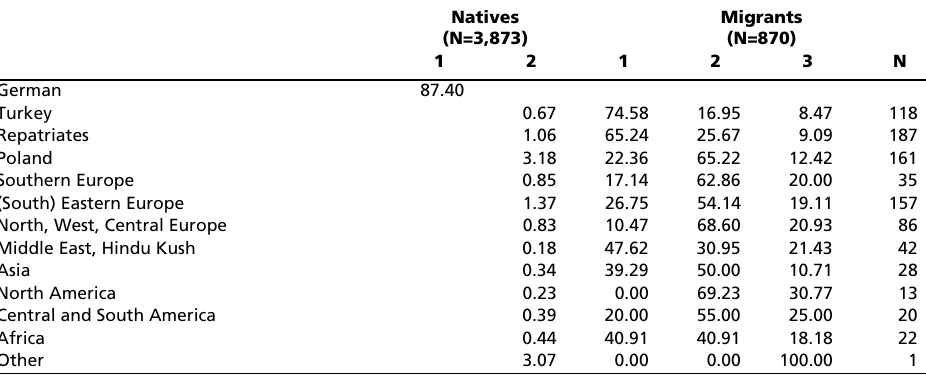
Natives Migrants (N=3,873) (N=870) 1